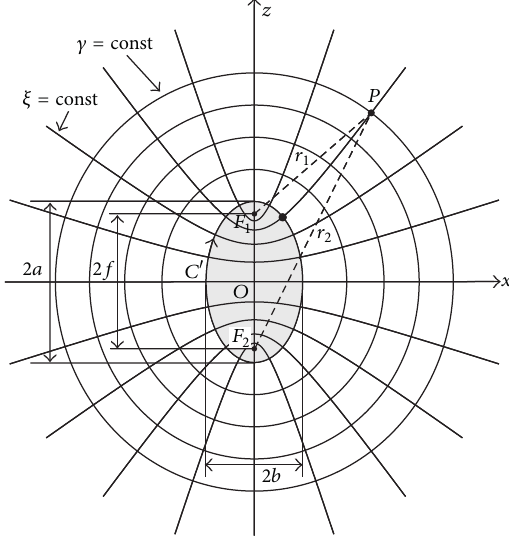
Figure 5: Ellipsoidal source modelling: prolate